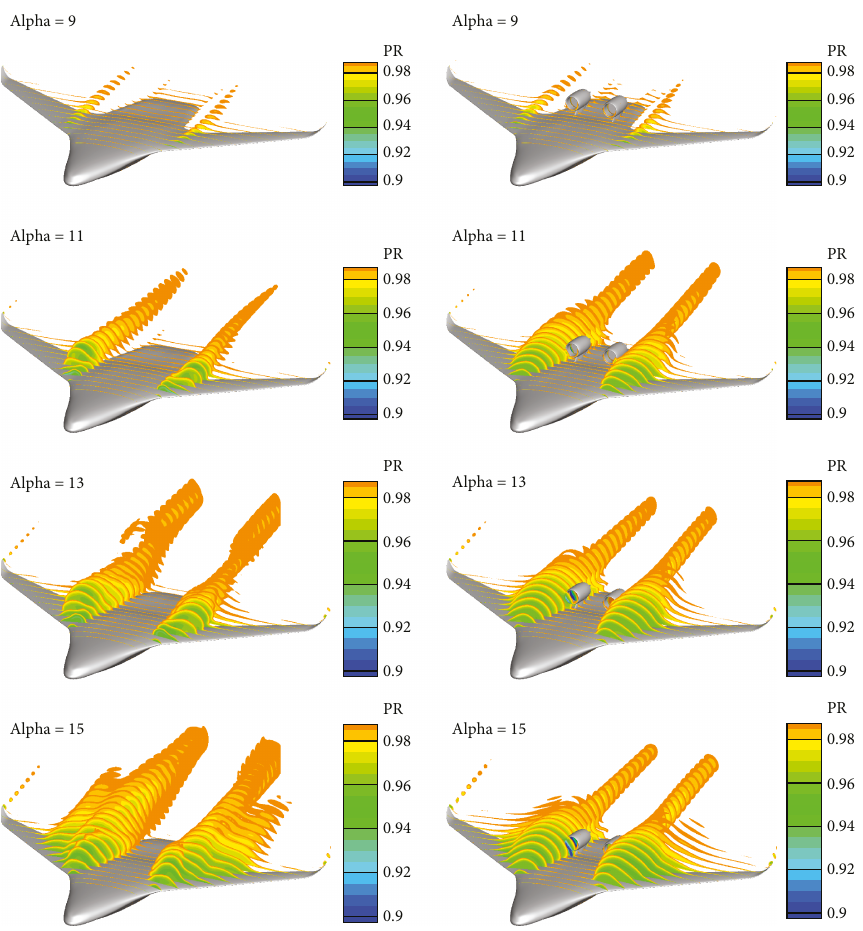
Figure 23: Upper surface PR distribution of the clean and powered con fi gurations at high angles and low speed.